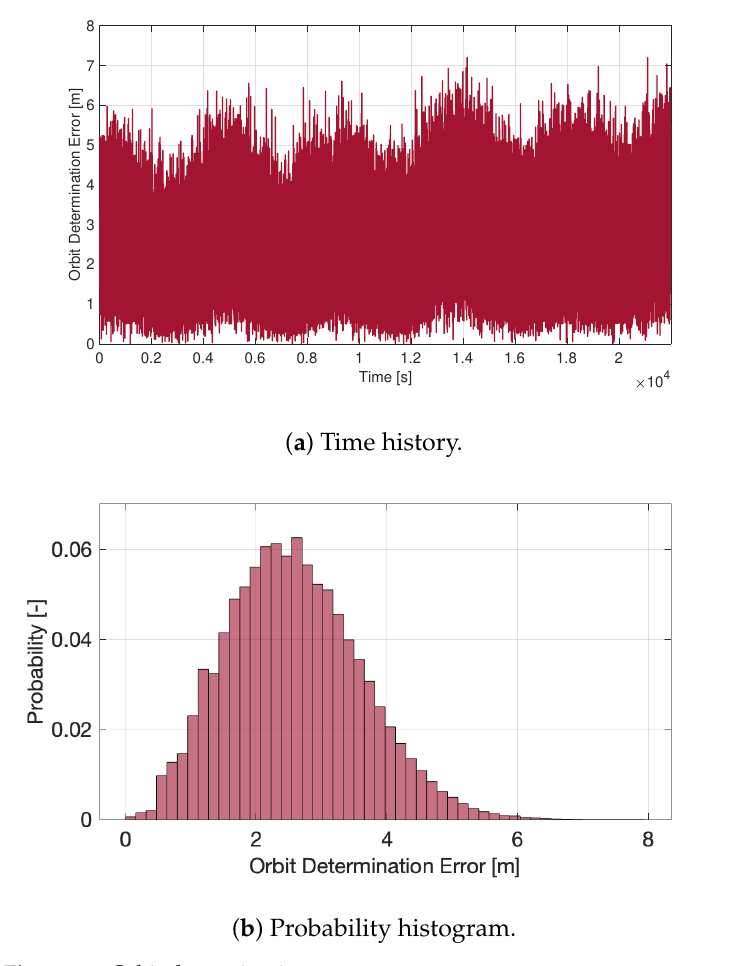
( b ) Probability histogram. Figure 17. Orbit determination